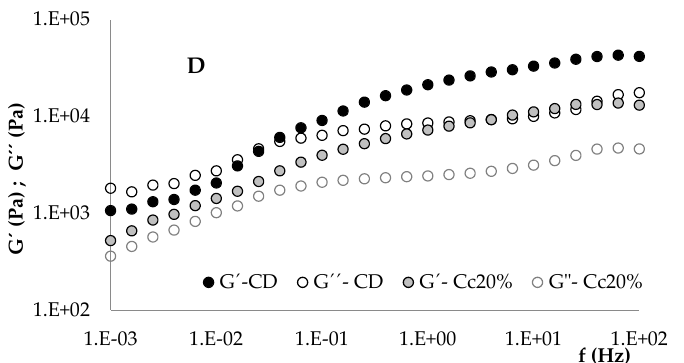
Figure 2. Rheology changes in viscoelastic functions, storage (G’, full symbols) and loss (G”, empty symbols) moduli, by the additions of curd cheese to dough (CcD5% up to CcD20% w / w ), compared with viscoelastic profile of the control dough (CD) (black round symbols): ( A ) CD vs. Cc5%; ( B ) CB vs. Cc10%; ( C ) CB vs. Cc15%; ( D ) CB vs. Cc20%.